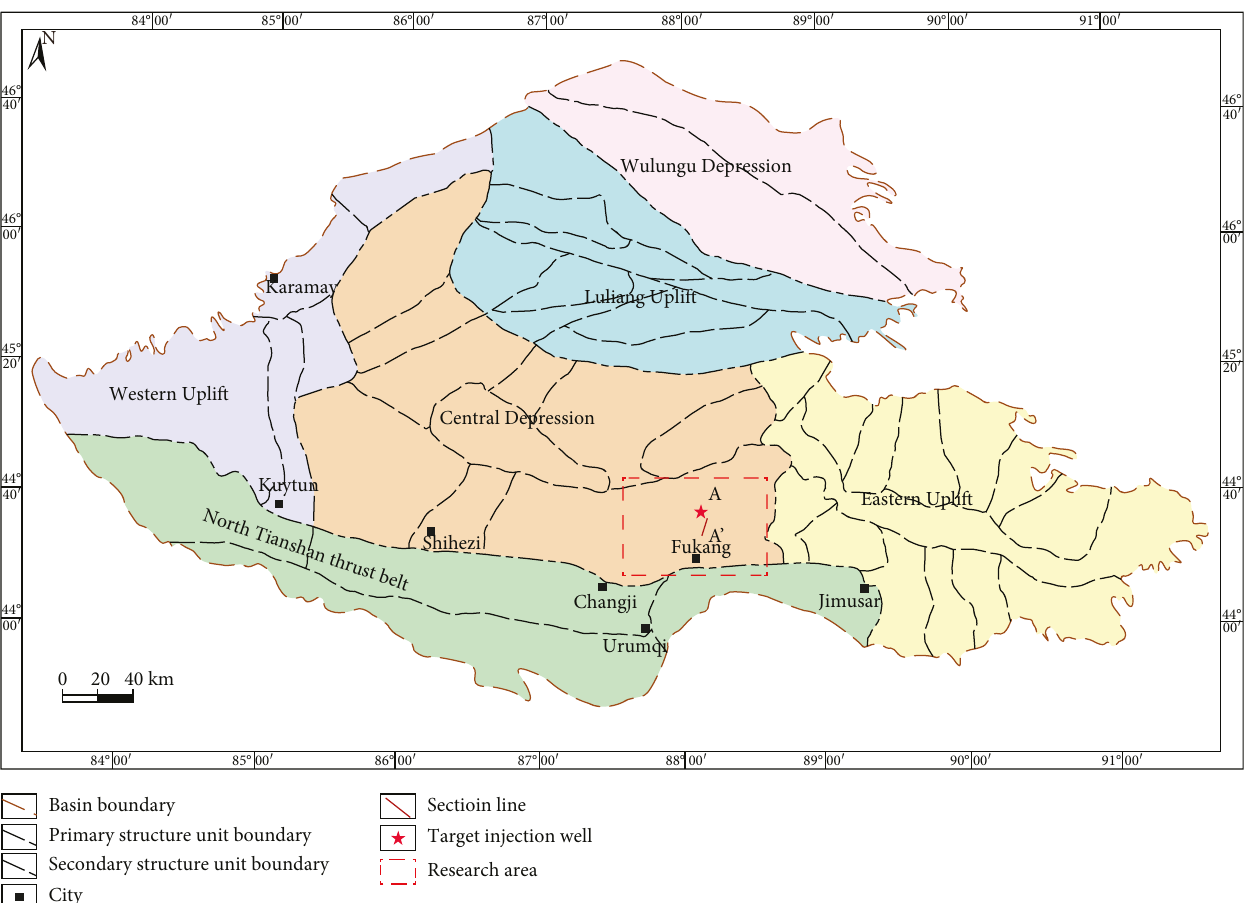
Figure 1: Division of the tectonic units in the Junggar Basin [22, 23].